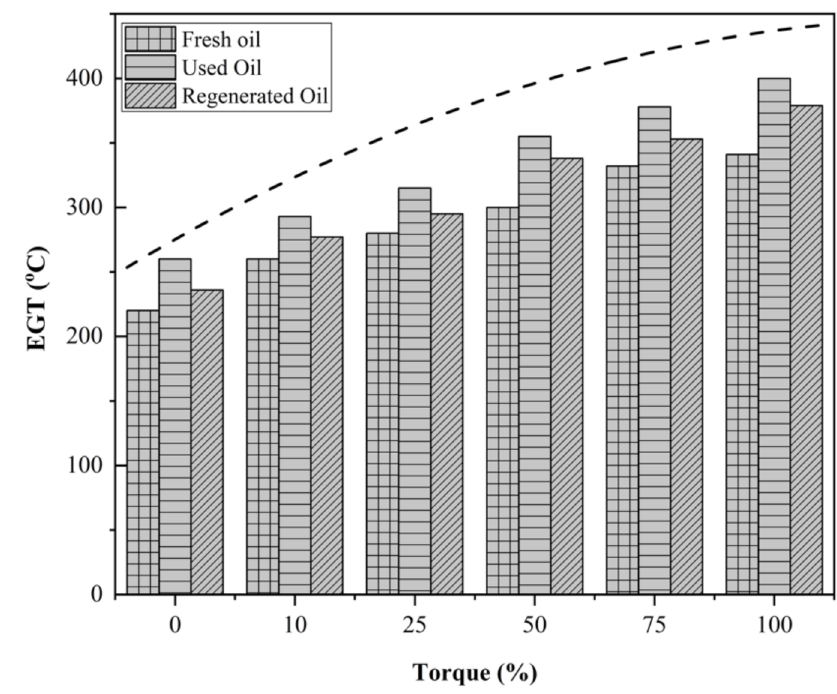
Figure 7. EGT variation with torque